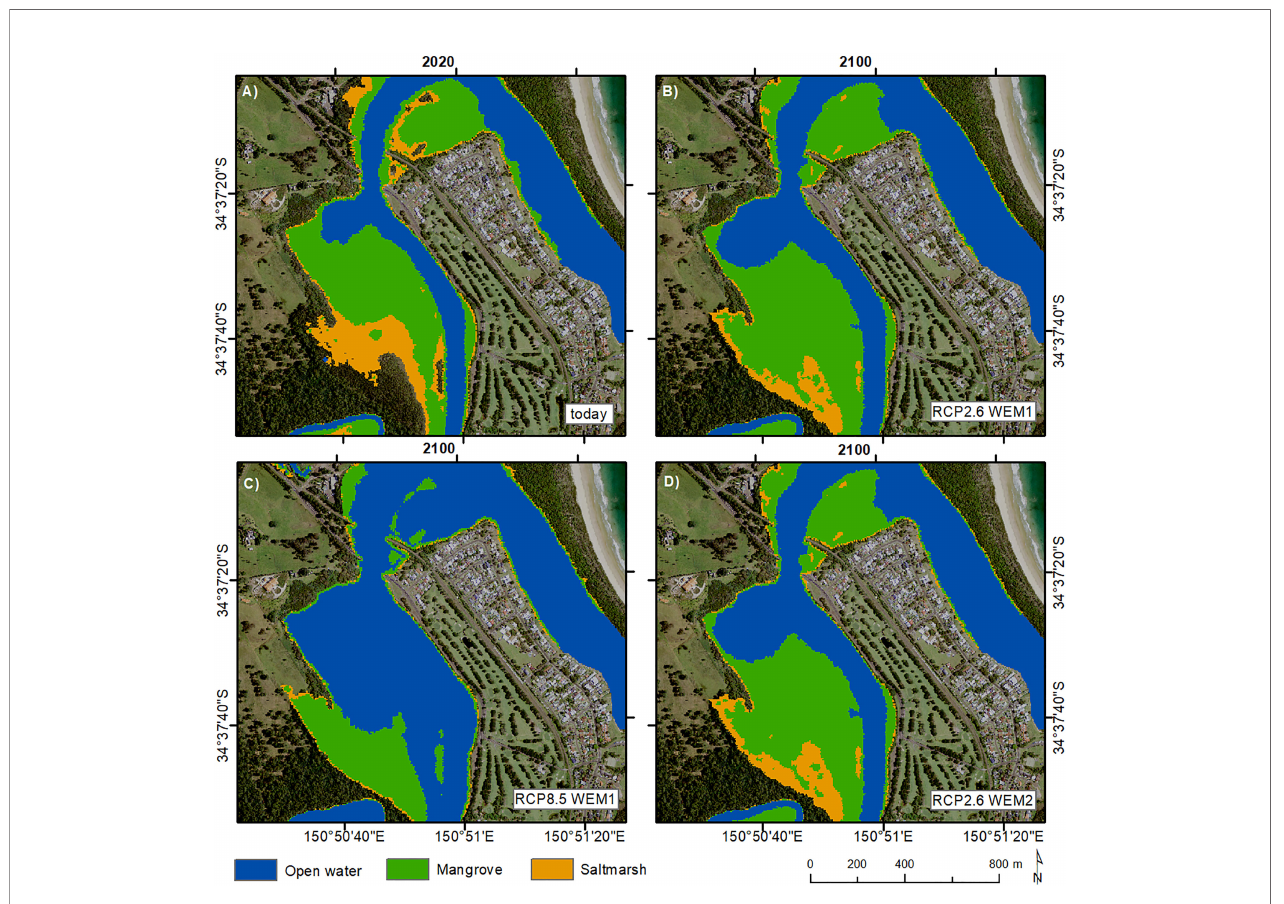
FIGURE 10 | Projections of intertidal wetland vegetation communities (mangrove and saltmarsh) for today (A) , WEM1 and low SLR (B) , WEM1 and high SLR (C) , and WEM2 and low SLR (D)